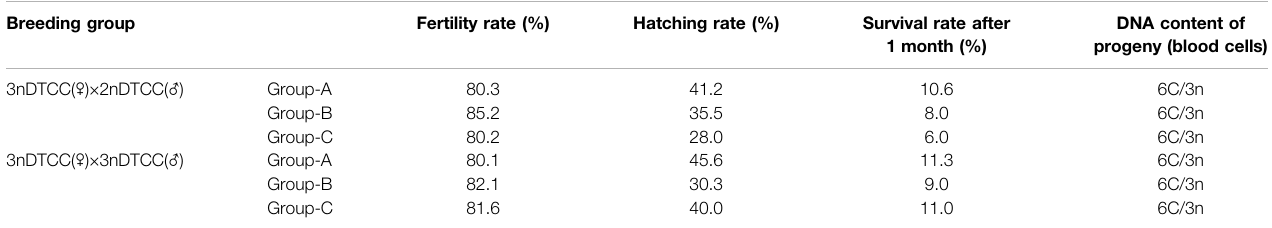
DNA content of 1 month (%) progeny (blood cells)